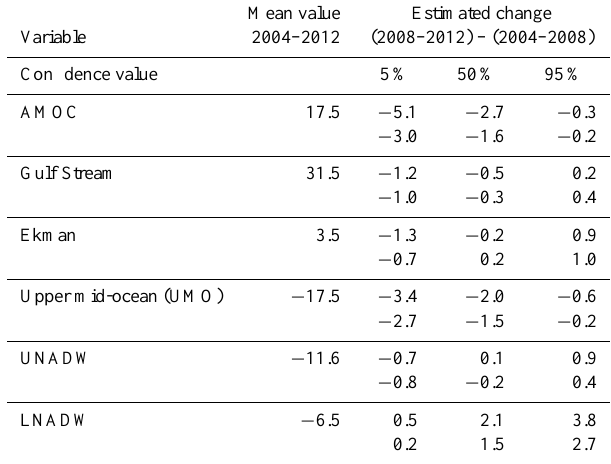
Table 2. Estimated changes for the AMOC at 26 ◦ N and its compo- nent parts between the period from April 2004 to March 2008 and the period from April 2008 to March 2012. Two values are shown for each variable. The first (upper) value includes the year starting in April 2009 and the second excludes 2009. Also shown are the 5 and 95 percentile values of the estimate. All values are Sv. Pos- itive implies increased northward transport (or reduced southward